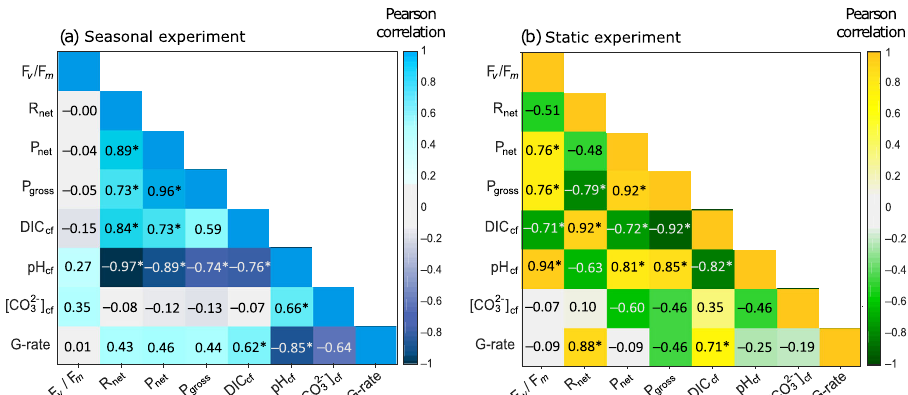
Fig. 4 Correlograms of physiological variables. Matrix of Pearson Correlation Coef fi cients for relationships between photochemical ef fi ciency (F v /F m ), net dark respiration rates (R net ), net photosynthesis rates (P net ), gross photosynthesis rates (P gross ), dissolved inorganic carbon in the calcifying fl uid (DIC cf ), pH of the calcifying fl uid (pH cf ), carbonate ion concentration in the calcifying fl uid ([CO 3 2- ] cf ), and the calci fi cation rate (G-rate) for ( a ) the seasonal experiment, and ( b ) the static experiment. Asterisk (*) denotes signi fi Table S2). The effects of temperature and light on metabolic productivity was therefore quite different between the seasonal experiment and the static experiment, with the temperature being more important on seasonal timescales and light being more important under static conditions.